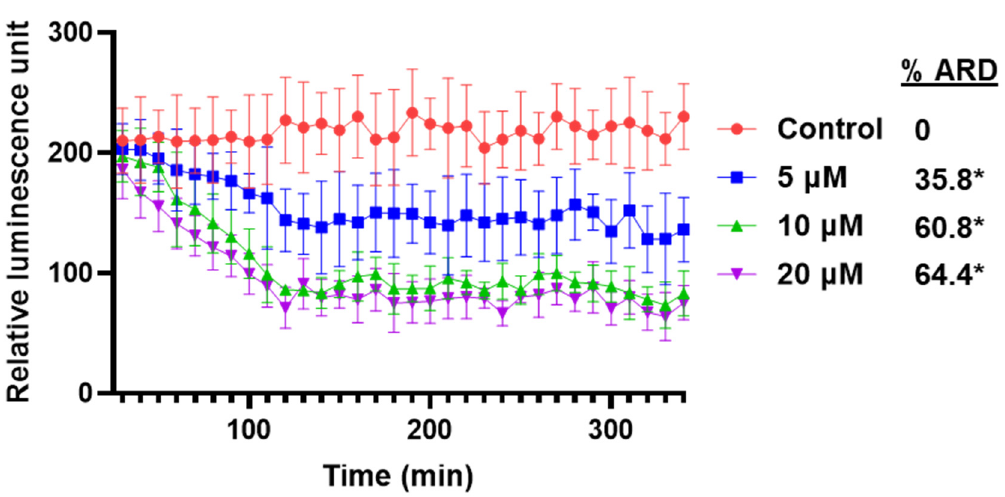
Figure 3. VNPP433-3 β -mediated degradation of AR occurs rapidly and is concentration- and time- dependent. CRISPR-edited 22Rv1 cells that express endogenous AR labeled with HiBiT and LgBiT were treated with 5, 10 and 20 µ M of VNPP433-3 β in presence of luminescence substrate Nano-Glo ® Endurazine™. Luminescence was measured every 10 min for 5 h and plotted against time using Graphpad Prism software. %ARD = % androgen receptor (f-AR) degradation following treatments with increasing concentrations of VNPP433-3 β . * p < 0.0001.